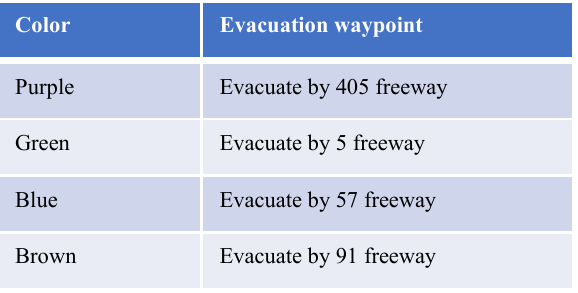
Table 3. Explanation of color codes in Map 2